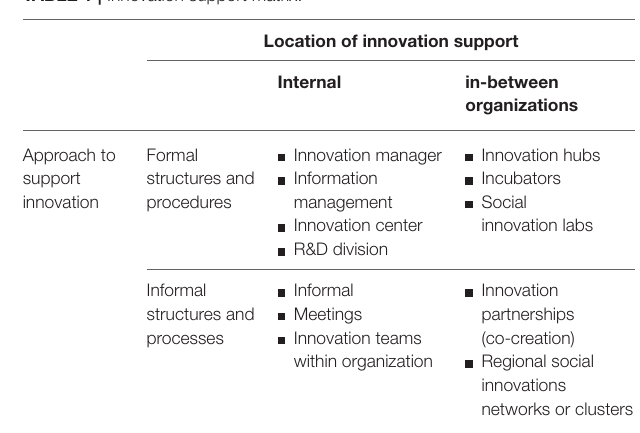
TABLE 1 | Innovation support